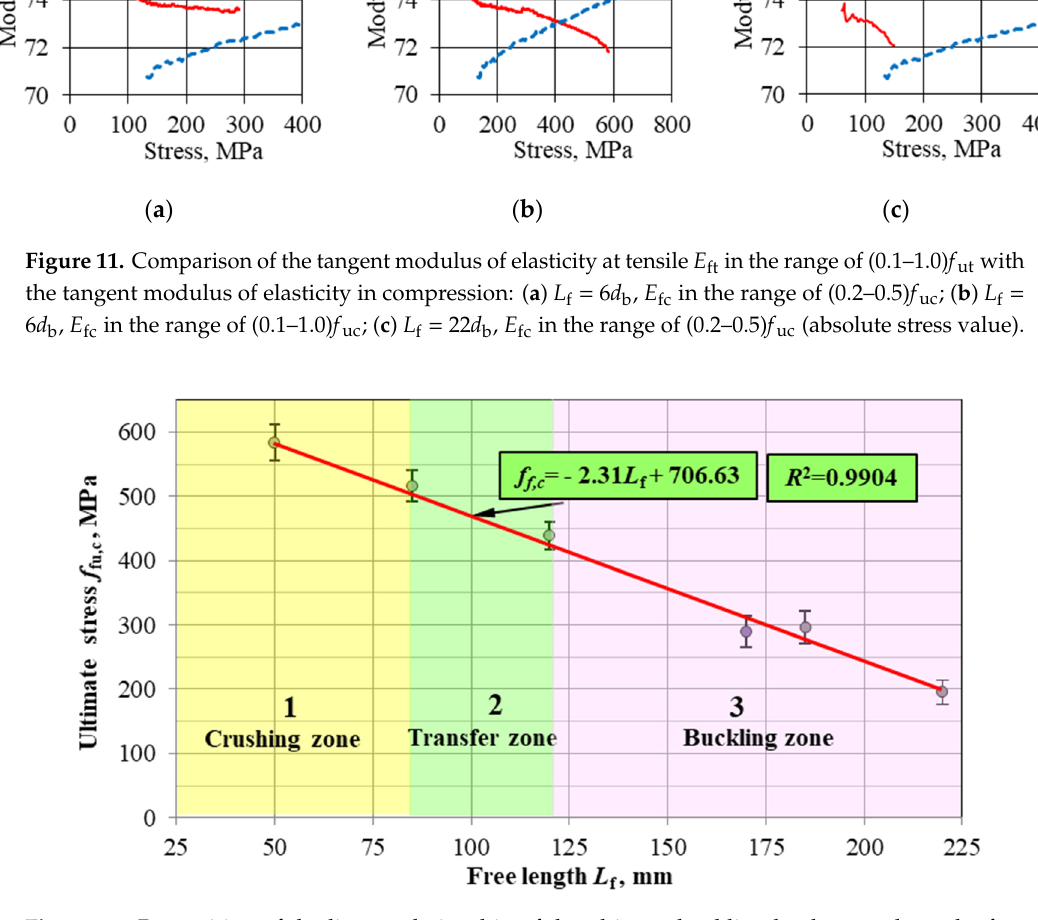
Figure 12. Proposition of the linear relationship of the ultimate buckling load strength on the free length (not anchored) for HFRP bars with a nominal diameter of 8 mm.